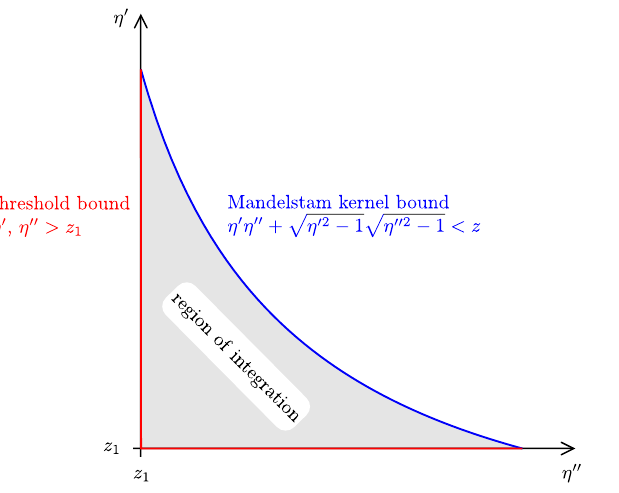
Figure 3 . The region of integration in equation (3.9). As s or t approaches the Landau curve from above, the integration region shrinks to zero. As a result, the double spectral density vanishes below the Landau curve z = 2 z 2 − 1 1